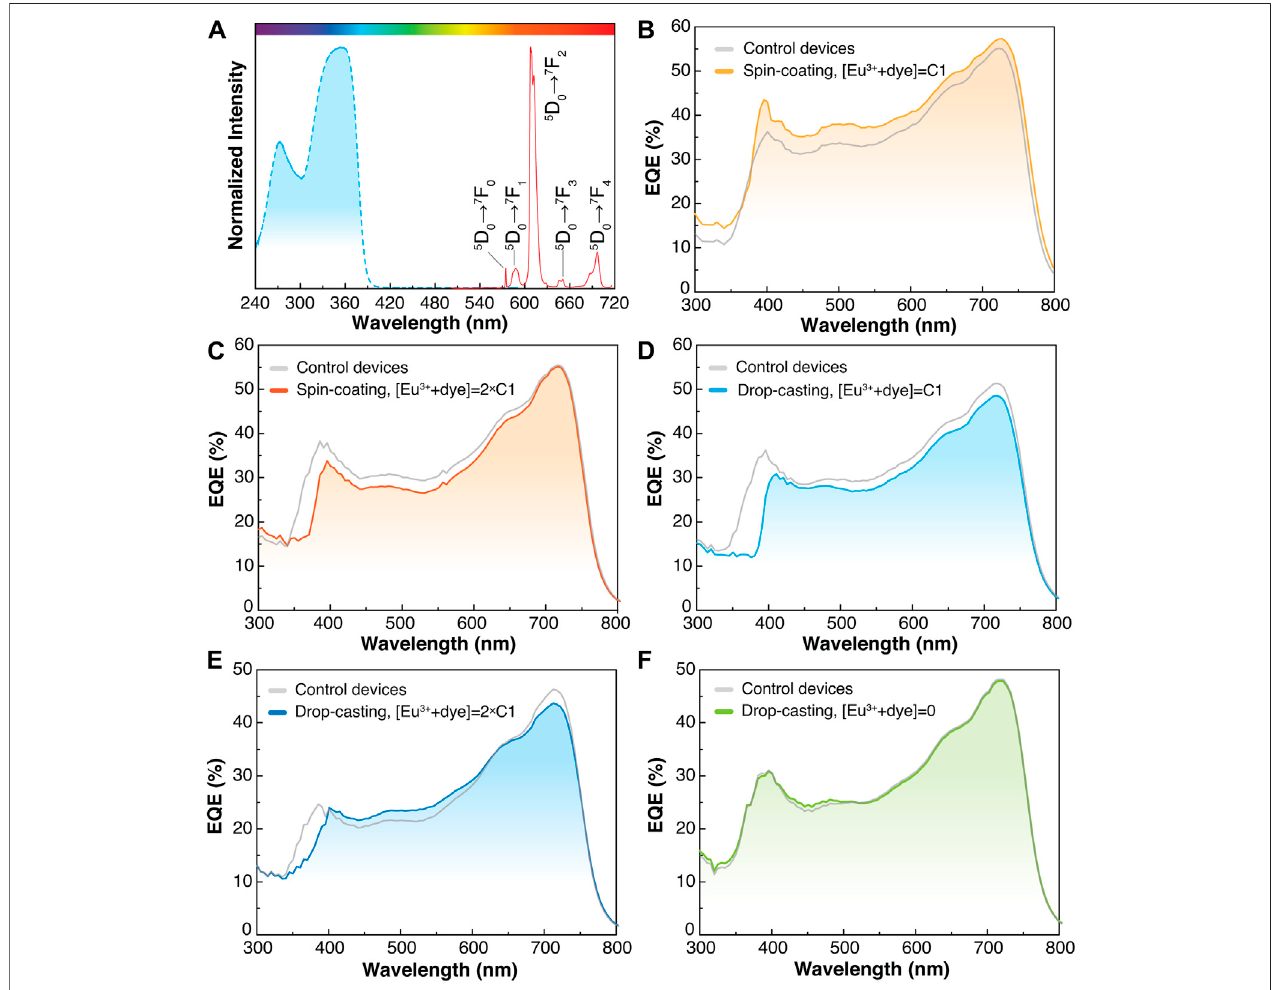
FIGURE 3| (A) Excitation (dashed line) and emission (solid line) spectra of dU6Eu monitored at 612 nm and excited at 365 nm, respectively. (B – F) EQE spectra of the dU6Eu/glass/ITO/PEDOT:PSS/PTB7-Th:ITIC/Ca/Al devices prepared in this study and comparison with those of the control